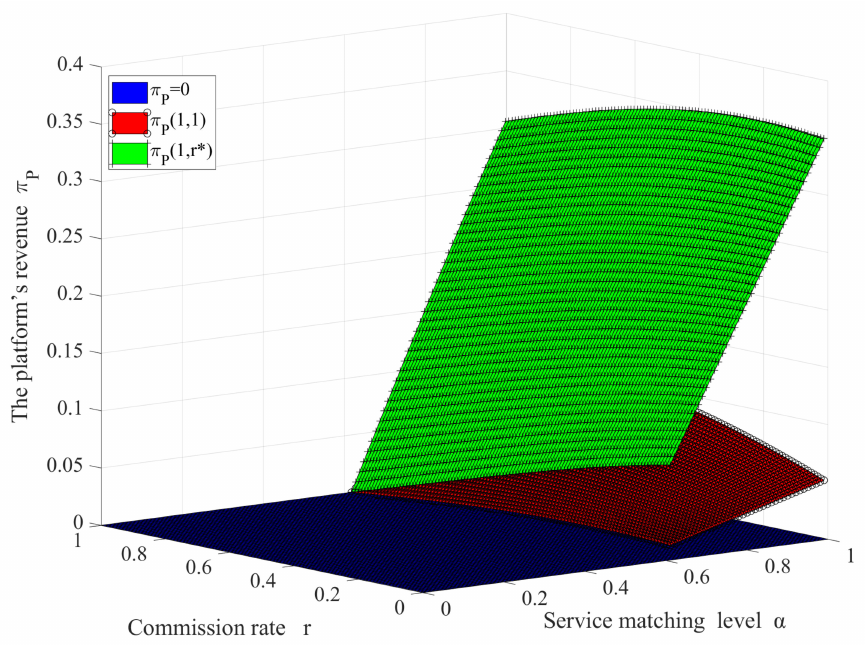
Figure 6. The platform’s revenue changes with the strategy π p ( 1,1 ) and π p ( 1,0 )